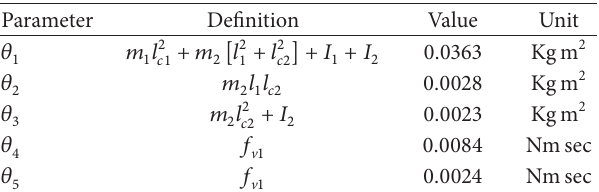
Table 2: Estimated parameters of the experimental robot arm; see (61) for reference.